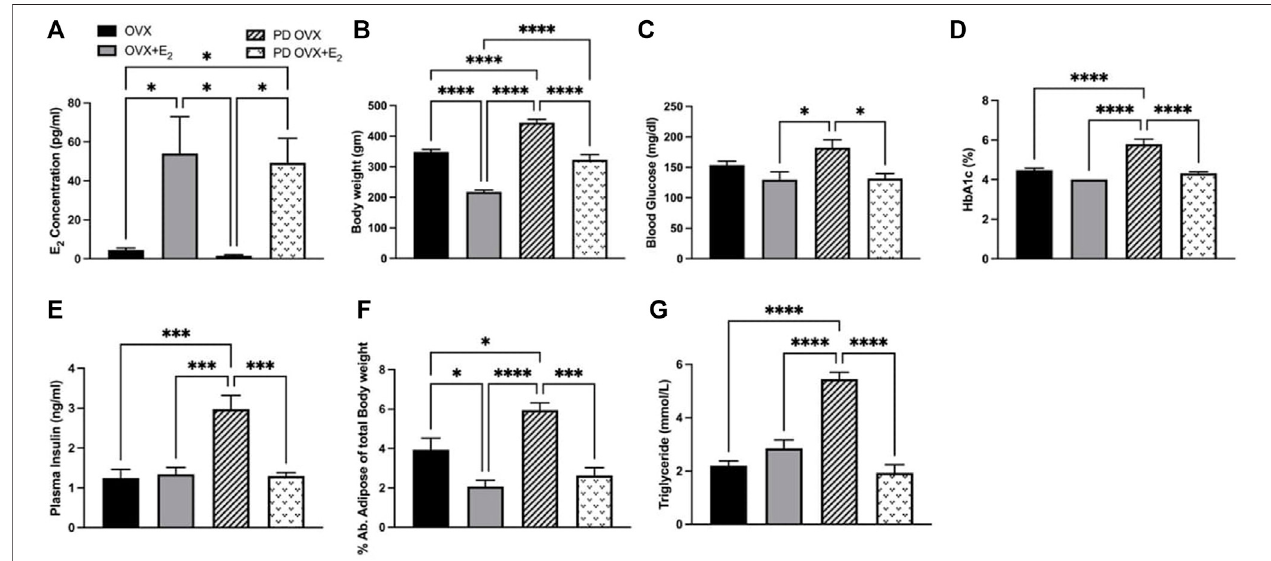
FIGURE1| Metabolic parameters ofovariectomized (OVX)and E 2 replaced (OVX+E 2 ) controland prediabetic(PD) rats. (A) Plasma estradiol (E 2 )concentration (B) Body weight (C) Blood glucose level (D) HbA1c (E) Plasma insulin level (F) Abdominal adipose tissue percentage to total body weight (G) Circulating triglyceride level. Values are represented asmean±SEM.Each bar representsthevalues obtained from n =5 – 6animals per group. Capped linesindicate signi fi cantdifferencesbetween two groups (* p < 0.05, *** p < 0.001, **** p = 0.0001), analyzed using one-way ANOVA followed by Tukey ’ s post hoc test.